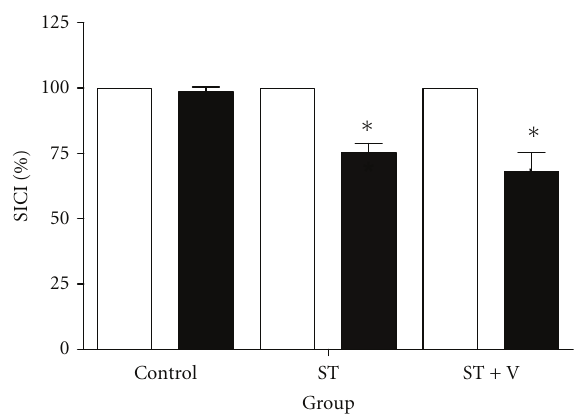
Figure 4: Mean ± SE SICI (expressed as a percentage change) for all groups before (light bars) and after training (dark bars). ∗ denotes a significant reduction in SICI following training for the ST and ST + V groups ( P < 0 . 016); however, no di ff erences in SICI following training were observed between the ST and ST + V groups ( P = 1 .